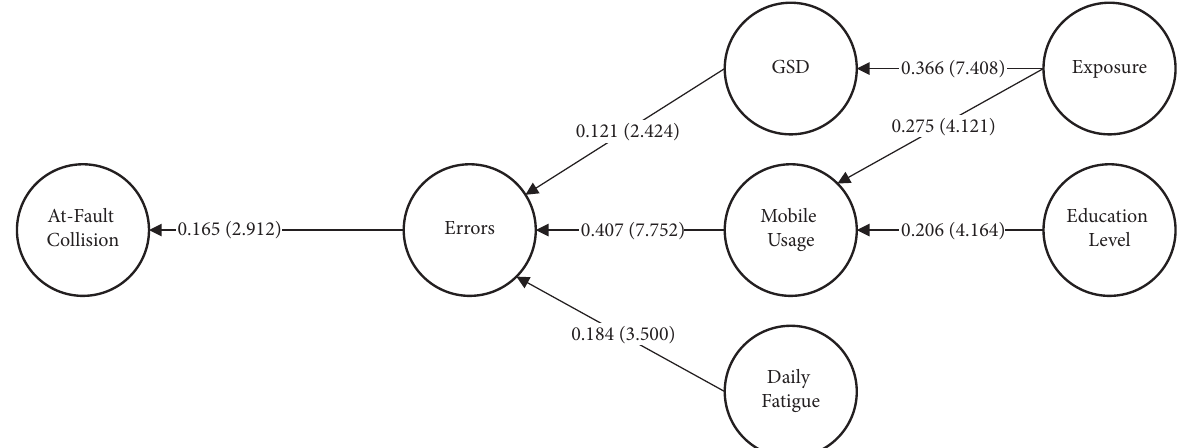
Figure 2: SEM model for the relationship between driver characteristics and at-fault collisions over 3 years; the numbers shown are path coefficients and the values in parentheses are their statistical significance ( t